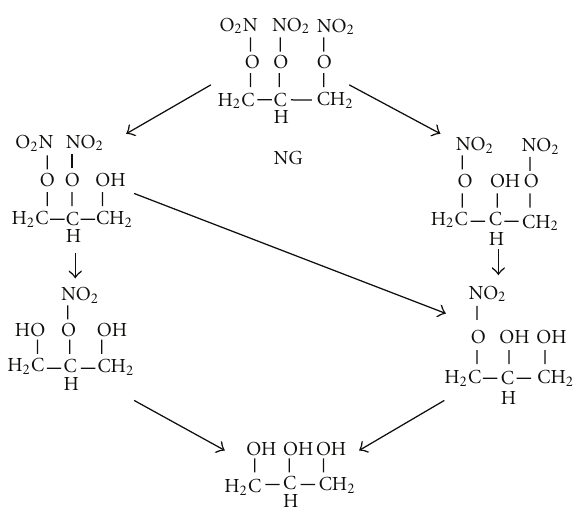
Figure 7: Biological transformation pathway for NG [272]. Repro- duced with kind permission from Elsevier.